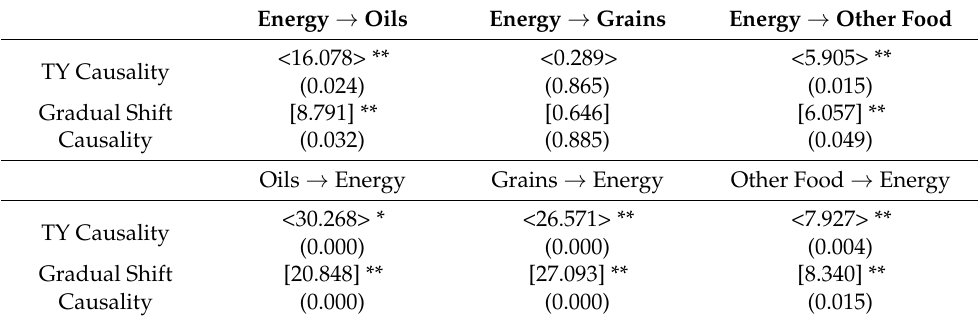
Table 3. Causality